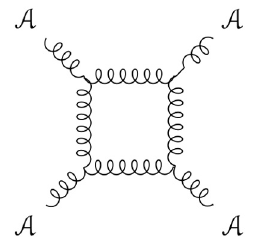
Figure 2 . The anomaly in holomorphic BF